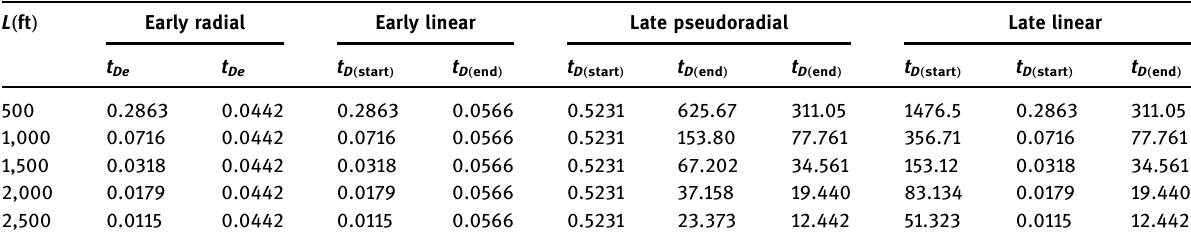
Table A2: Dimensionless fl ow period time for varying L D